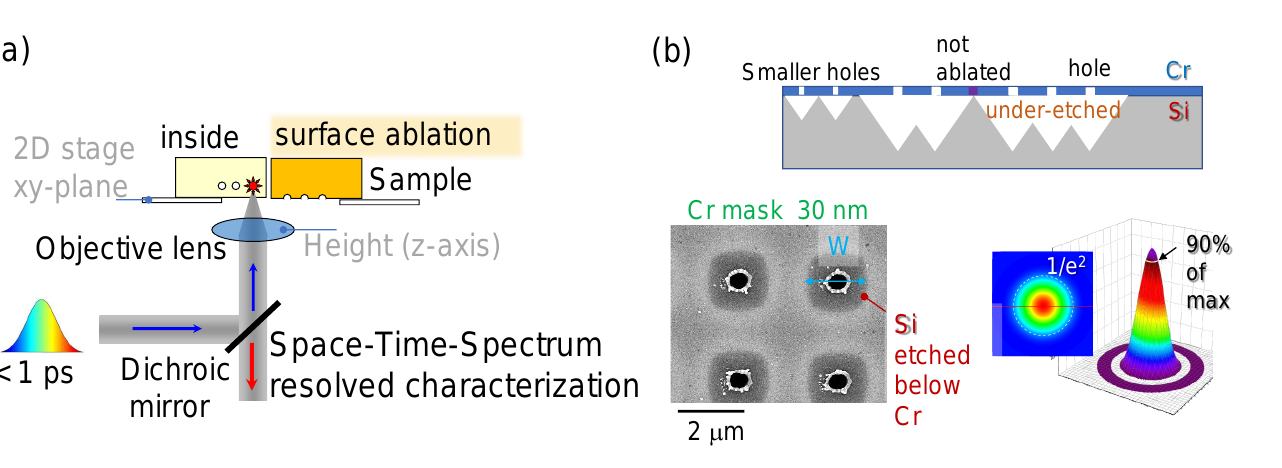
Figure 1. ( a ) Three-dimensional patterning/printing with ultra-short laser pulses with stages de- livering lateral xy in-plane positioning and an objective lens height control provides depth (z-axis) position of the focal spot inside of on the surface of the sample. ( b ) Schematics: plasma under- etched profile thorough the holes ablated in Cr mask (20–50 nm thick). SEM image of Cr-mask after etching through ablated holes. Threshold effect of focal intensity distribution tuned to the material modification/ablation